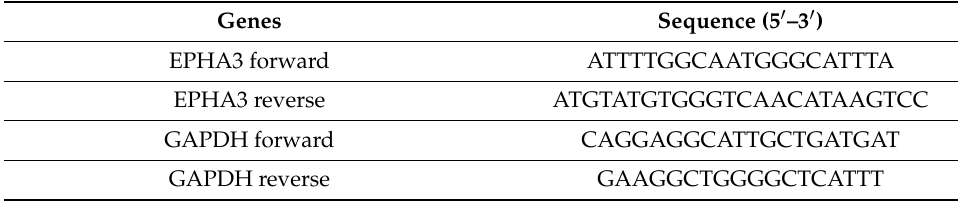
Table 2. Primer sequences adopted in RT-qPCR